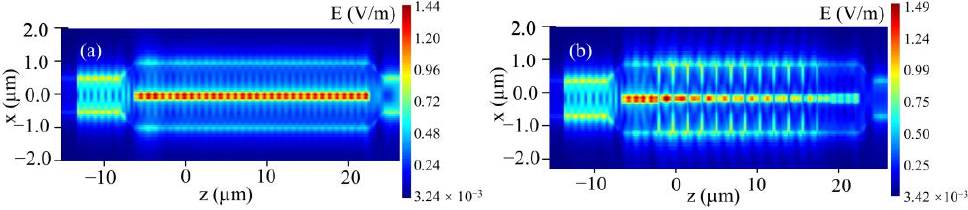
Figure 6. The electric field distribution in the propagating direction: ( a ) slot waveguide; ( b ) SWGS waveguide.